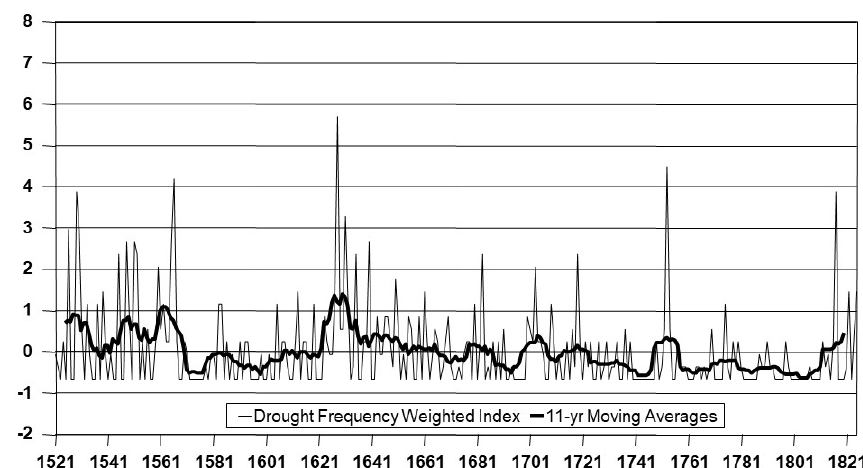
Figure 4. Drought frequency weighted index. Standardised values. City of Barcelona (1521–1825). Data improved from Martín-Vide and Barriendos (1995).